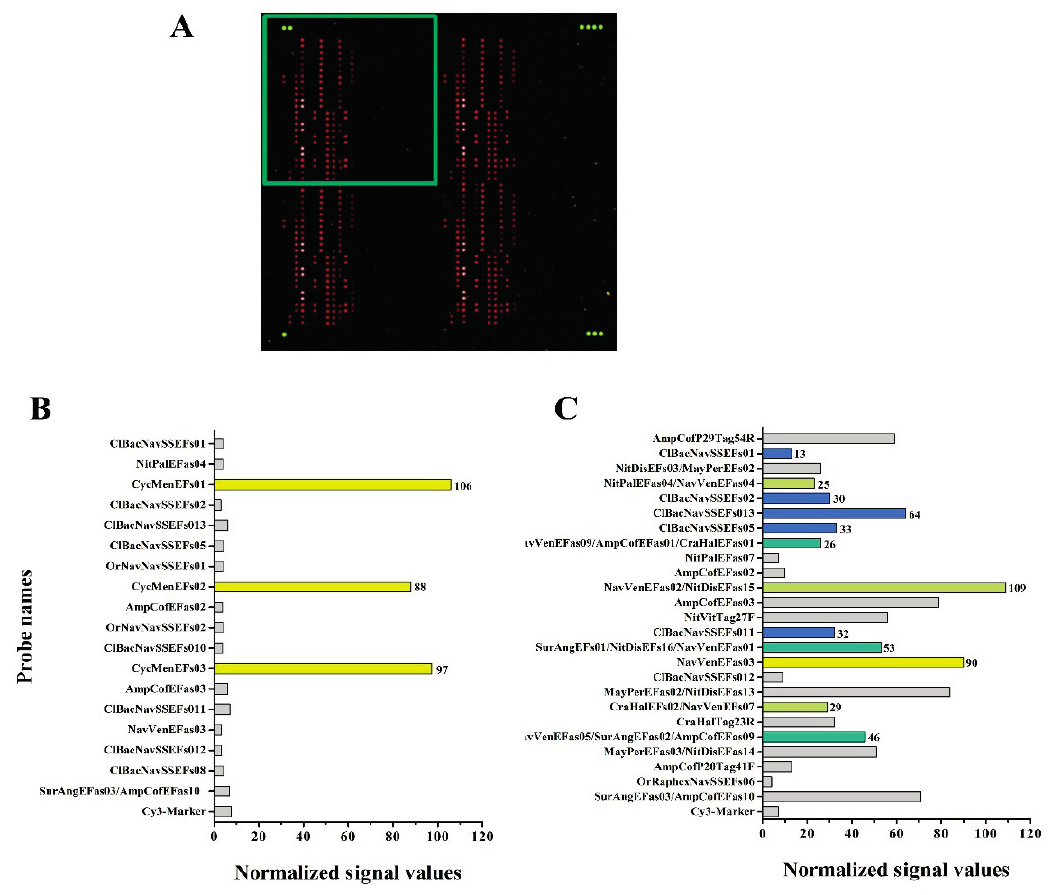
Figure 6. Results of microarray hybridization experiments targeting eEF1-a gene. ( A ) Image of an hybridized slide after scanning: the green dots indicate the Cy3-Marker spotted at the four corners of the slide, the green square indicates one of the four sectors of each block of the array. In the two graphs are reported the values of normalized signals obtained after hybridization with a fluorescent fragment of eEF1-a gene from Cyclotella meneghiniana ( B ) and Navicula veneta ( C ). On the Y-axis are reported the probes producing a fluorescent signal after hybridization: the color code of the bars follows the scheme reported in Table S1 and in the text. Grey bars indicate false-positive